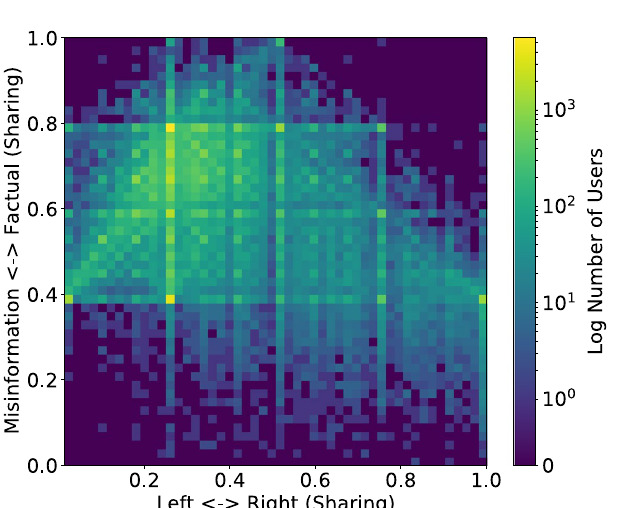
Figure 2. Relationship between dimensions of polarization. Color represents number of users given polarization scores along the political and factual dimensions (Pearson’s correlation r = − 0.198 ( p < 0.001 )